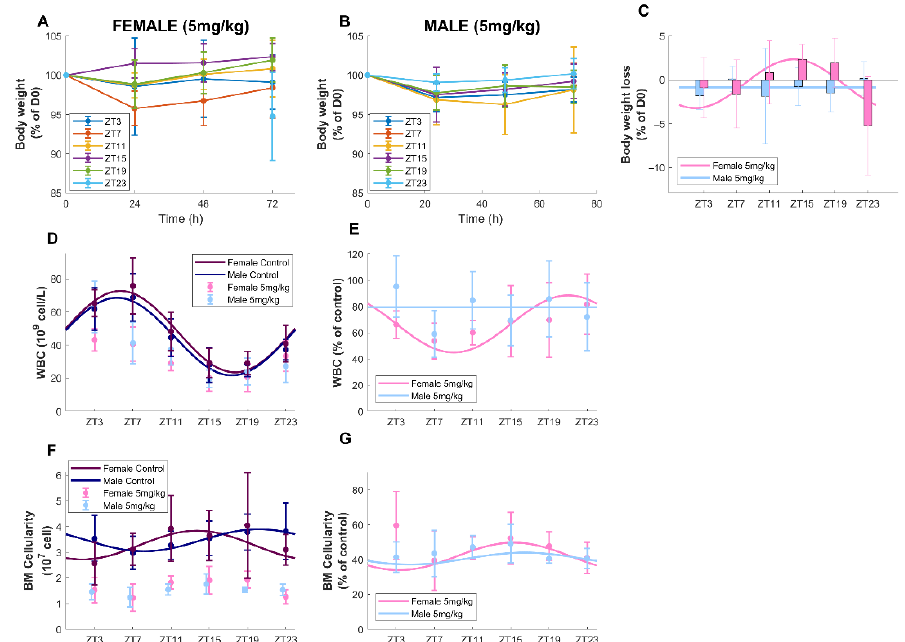
Figure 4. Sex- and timing-dependent body-weight loss (BWL), circulating white blood cells, bone marrow cellularity counts after oxaliplatin injection. ( A , B ) BWL over the 72 h following a single administration of oxaliplatin at indicated dose and times of administration (ZT). ( C ) Circadian rhythms of BWL 72 h after oxaliplatin injection, raw data (mean ± SD) and best-fit cosinor (curves). ( D , E ) WBC and ( F , G ) bone marrow cellularity. Panels ( D , F ) show cell concentrations in control and treated datapoints (mean ± SD) conditions. Panels ( E , G ) show ratios between treated and control conditions (datapoints, mean ± SD). On all panels, solid lines are the best-fit significant cosine curves.